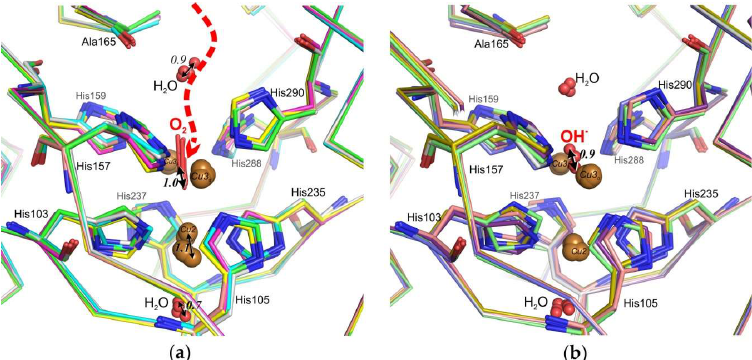
Figure 3. View of TNC at superposition of the monomers His165Ala of asymmetric unit. ( a ) “O 2 – –state”, ( b ) “Resting state”. The dotted line shows the T3 β tunnel. The distances between the extreme positions of atoms are shown in angstroms.